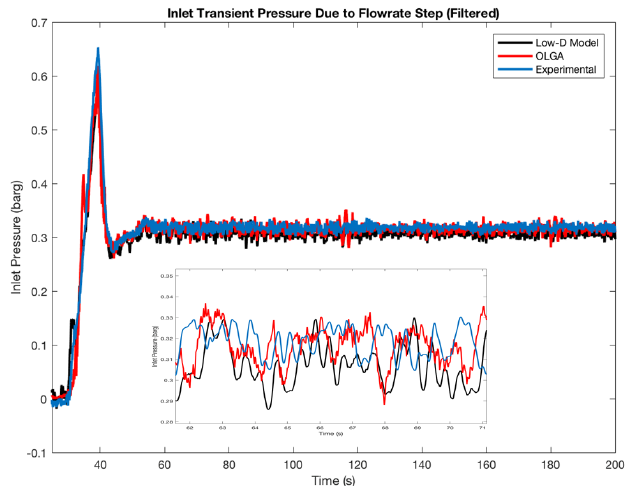
Figure 14. Experimental vs. simulations (Inlet Pressure, liquid with entrained air/case 1).